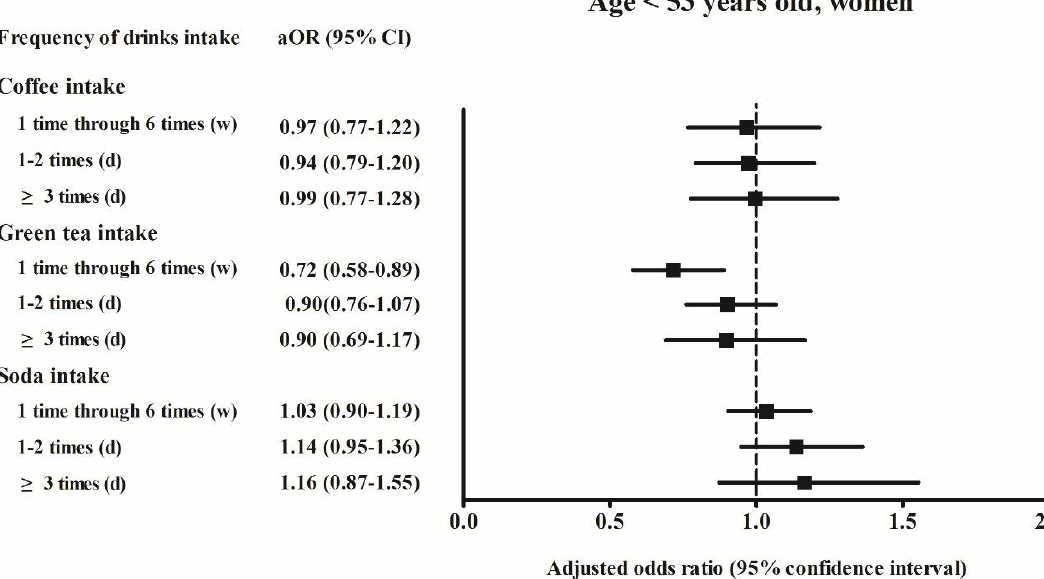
Figure 5. The adjusted odds ratio of the hyperuricemia according to the frequency of coffee/green tea/soda (soft drink) intake in the age < 53 years old women. Fully-adjusted model (age, BMI, income, past medical histories, smoking, alcohol consumption, nutritional intake, frequency of coffee, green tea, and soft drink intake) was used.